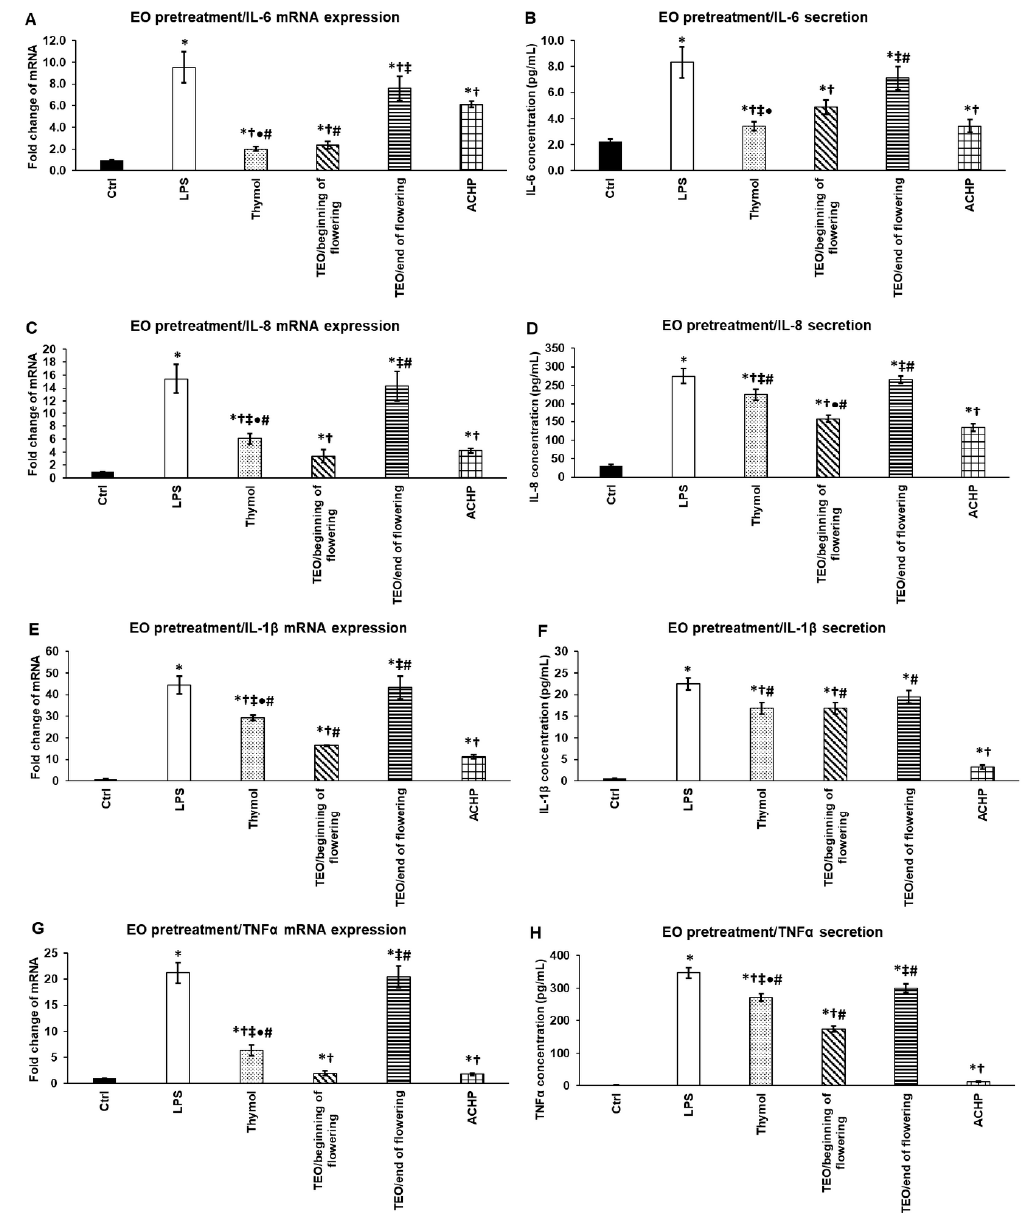
Figure 9. Effects of thymol, TEOs, and ACHP NF κ B inhibitor pretreatments on mRNA ( A , C , E , G ) and protein ( B , D , F , H ) levels of proinflammatory cytokines IL-6, IL-8, IL-1 β , and TNF- α . THP-1 cells were pretreated with 500-fold diluted thymol, TEOs, and 5 µ M ACHP for 24 h and then with 100 ng/mL LPS for 24 h. DMSO administration was used as a control of the treated cells. Real-time PCR for the proinflammatory cytokines was performed with SYBR green protocol. β -actin was used as housekeeping gene, and the relative expression of controls was regarded as 1. Proinflammatory cytokine secretions were determined using IL-6-, IL-8-, IL-1 β -, and TNF- α -specific ELISA kits according to the manufacturer’s protocols. The columns represent mean values, and error bars represent standard deviation (SD) for three independent experiments (n = 3). The assays were carried out in triplicate in each experiment. Asterisk indicates p < 0.05 compared to control. Cross marks p < 0.05 compared to LPS treatment. Double cross shows p < 0.05 compared to TEO/beginning of flowering. Bullet marks p < 0.05 compared to TEO/end of flowering. Number sign indicates p < 0.05 compared to ACHP treatment. Statistical analysis was carried out by two-way ANOVA followed by Scheffe’s post hoc